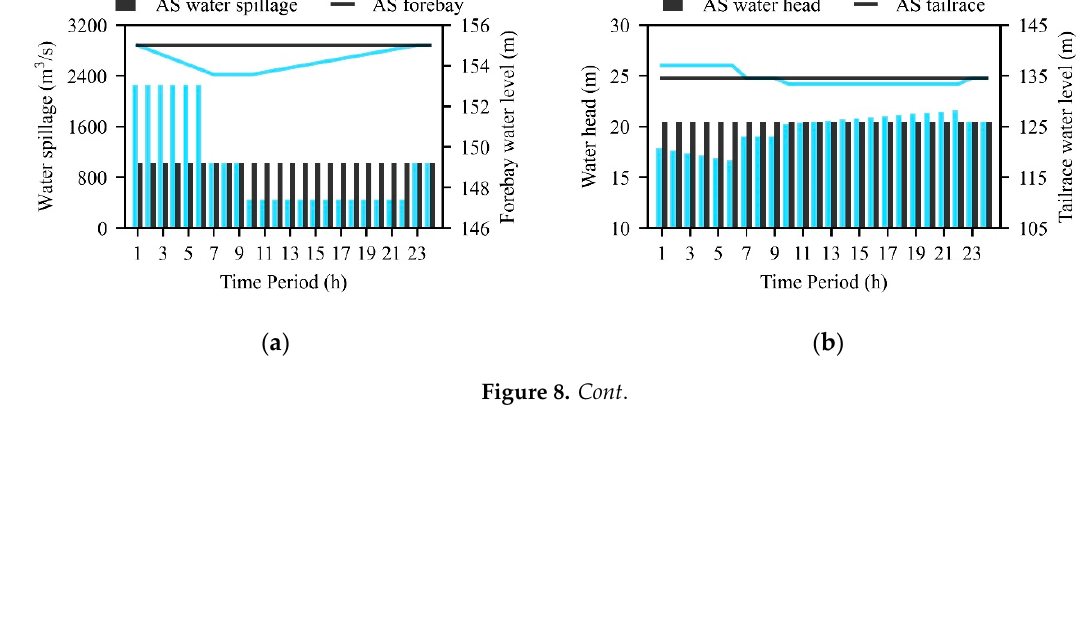
Figure 7. Comparsion of power output results of SPM and AS.